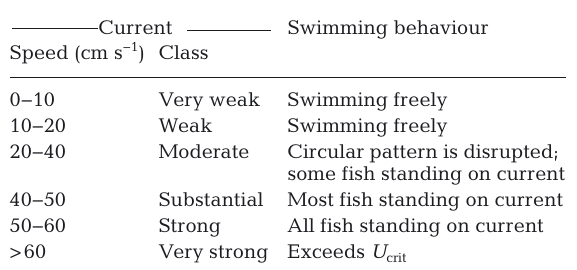
Table 2. Definition of current classes based on established limits related to the onset of behavioural changes and